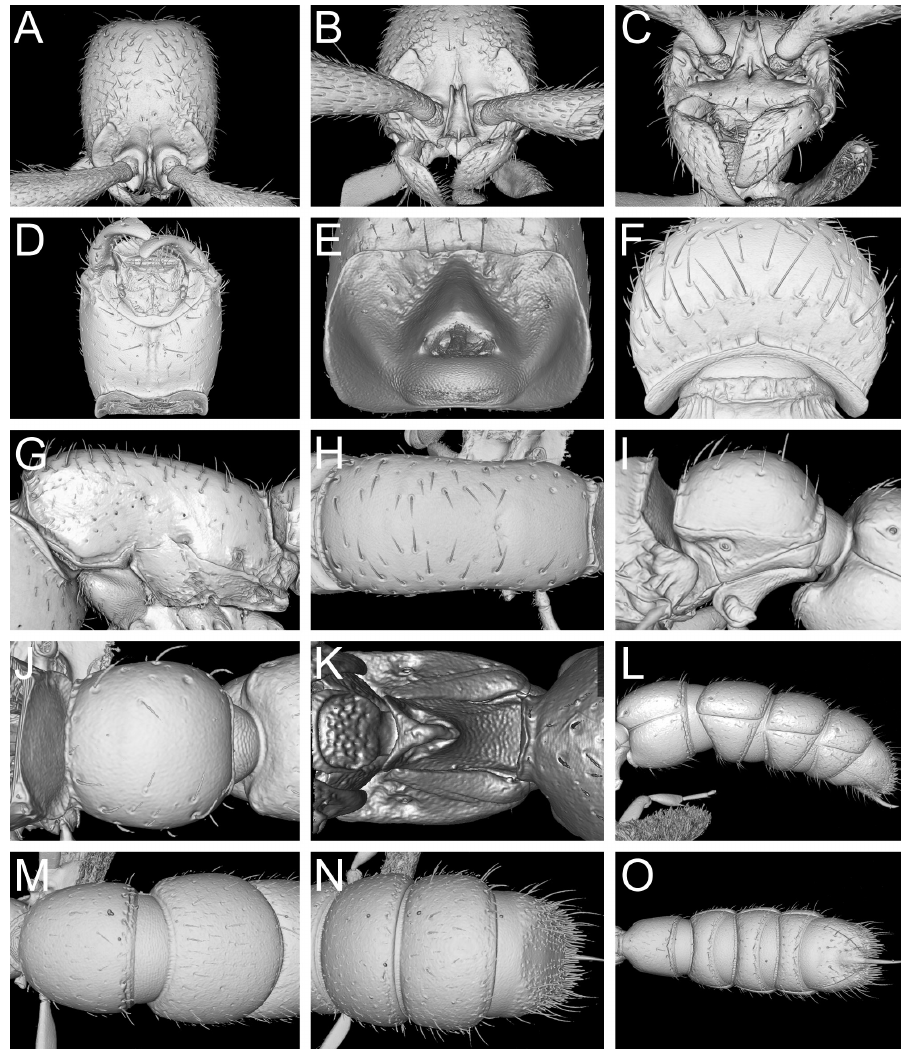
Figure 10. Shaded surface display volume renderings of 3D models of Zasphinctus sarowiwai sp. n. holotype worker (CASENT0764654). A Head in full-face dorsal view B Head in anterodorsal view C Anterior ce- phalic dorsum and mandibles in anterodorsal view D Head in ventral view E Occiput in posterior view (ven- tral head facing upwards) F Head in posterodorsal view G Mesosoma in profile H Mesosoma in dorsal view I Abdominal segment II (petiole) in profile J Abdominal segment II (petiole) in dorsal view K Abdominal seg- ment II (petiole) in ventral view L Abdominal segments III–VII in profile M Abdominal segments III and IV in dorsal view N Abdominal segments V–VII in dorsal view O Abdominal segments III–VII in ventral